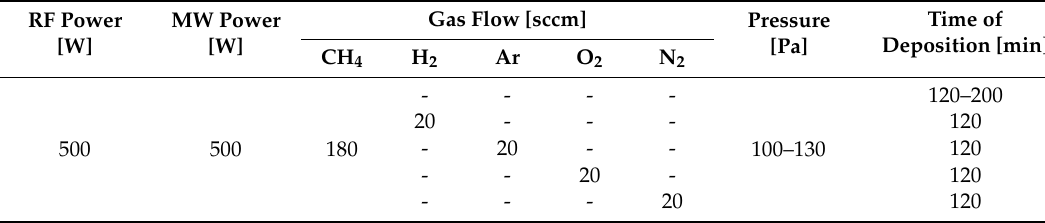
Table 1. Parameters of carbon powder production